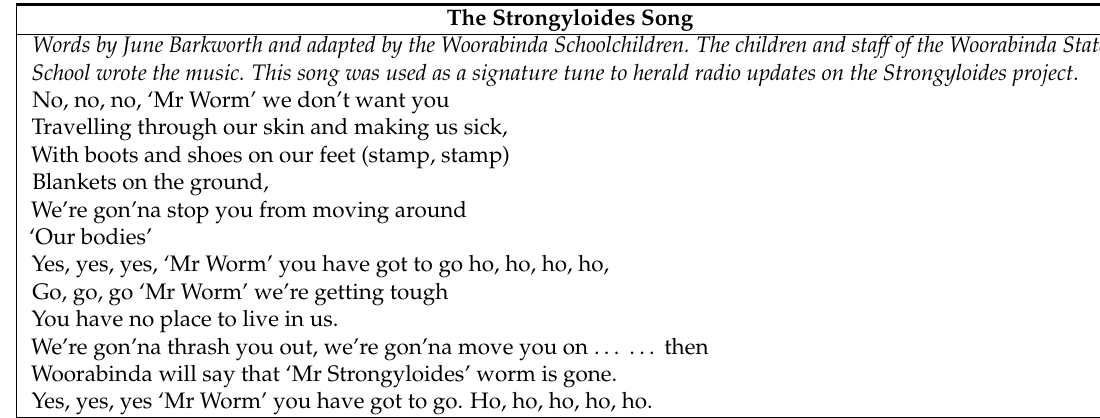
Table 2. The Strongyloides Song Developed and Sung by the Woorabinda State Primary Schoolchildren. The Strongyloides Song